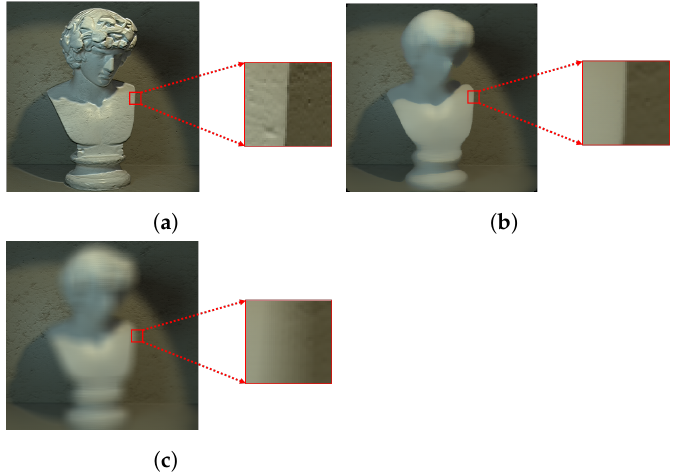
Figure 7. ( a ) Central sub-aperture image of a LF image, ( b ) focal stack image refocused on the background using median pixel values and ( c ) focal stack image refocused on the background using averaged pixel values and magnified region at depth discontinuity for each